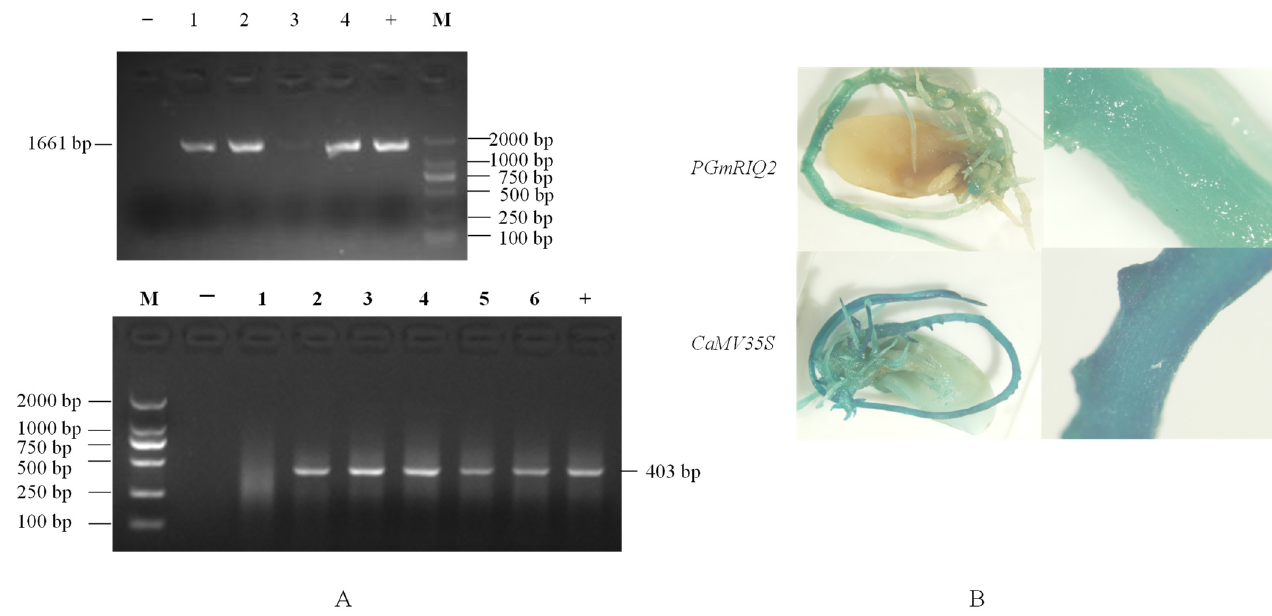
Figure 5. PCR detection of transgenic soybean root tissue and GUS histochemical staining of soybean root tissue. ( A ) PCR detection of transgenic soybean root tissue. 1–6: different transgenic roots GUS pCAMBIA3301GmRIQ2::GUS PCR ampli fi cation bands; +: positive control; − : negative control; M: DNA Marker (DL2000). ( B ) Transgenic pCAMBIA3301PGmRIQ2::GUS and pCAMBIA3301 soybean roots. Table 5. Comparison of induction and transformation of hairy roots by different recombinant ex ‐ pression vectors.